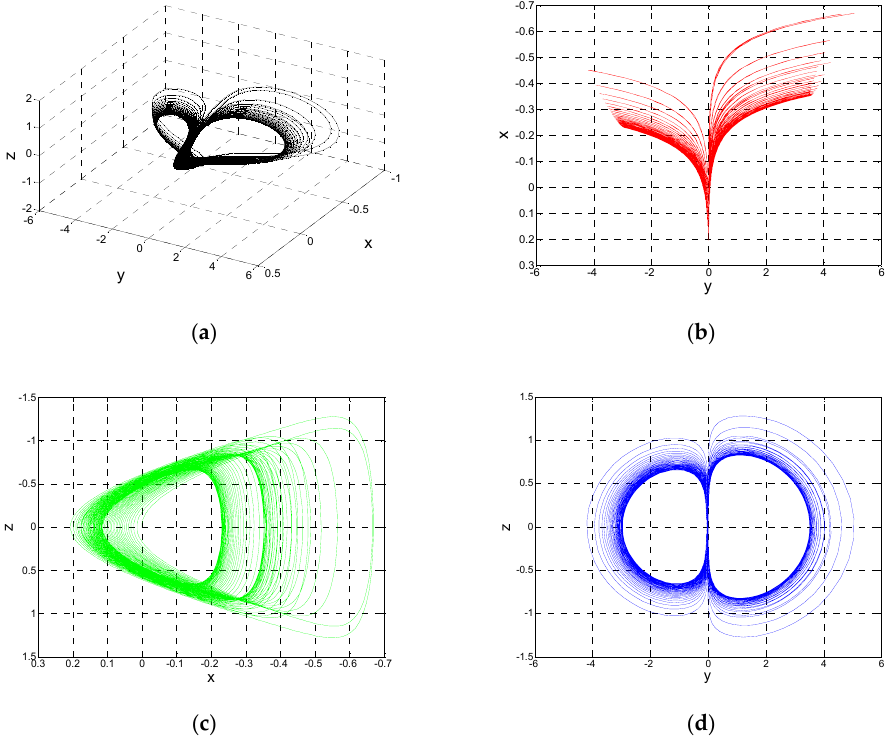
Figure 1. ( a ) 3D projection of chaotic attractor system; ( b ) XY phase plane; ( c ) XZ phase plane; ( d ) YZ phase plane.